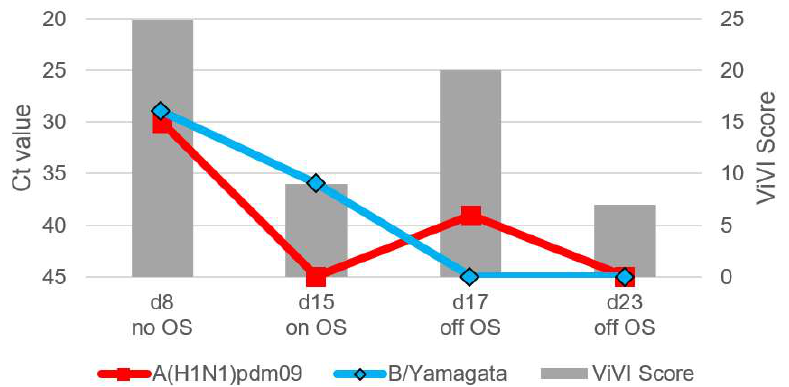
Figure 6. Patient 3 presenting with influenza A/B virus dual infection. Virus load (left inverted vertical axis) as approximated by Ct values correlated with ViVI Scores (right vertical axis) reflecting increasing disease severity with increasing values.